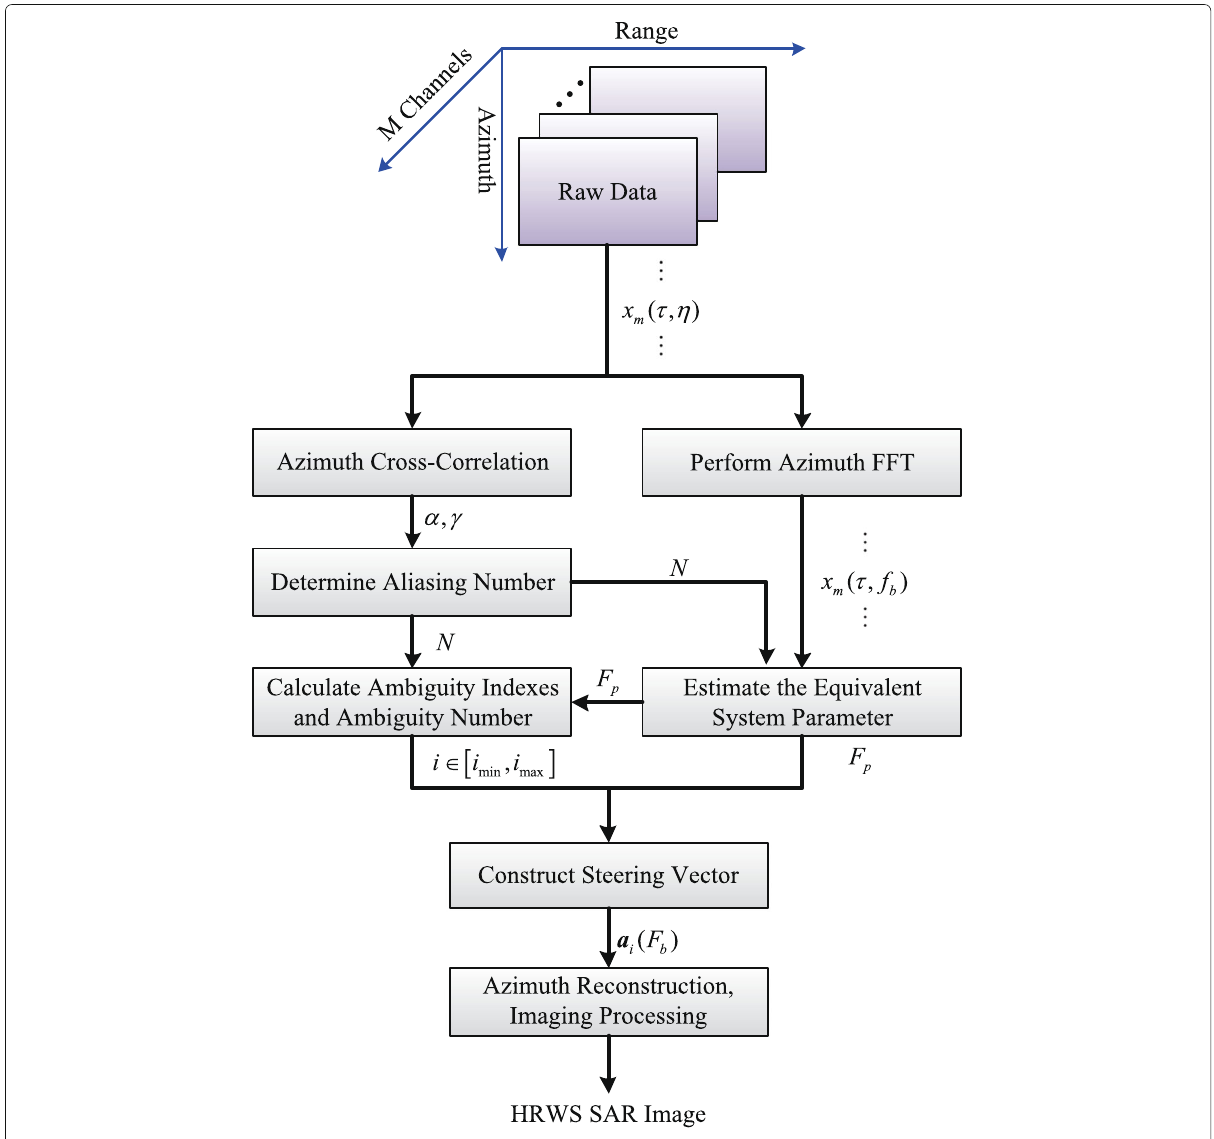
Fig. 4 Algorithm steps of the proposed adaptive azimuth reconstruction method for multichannel HRWS SAR